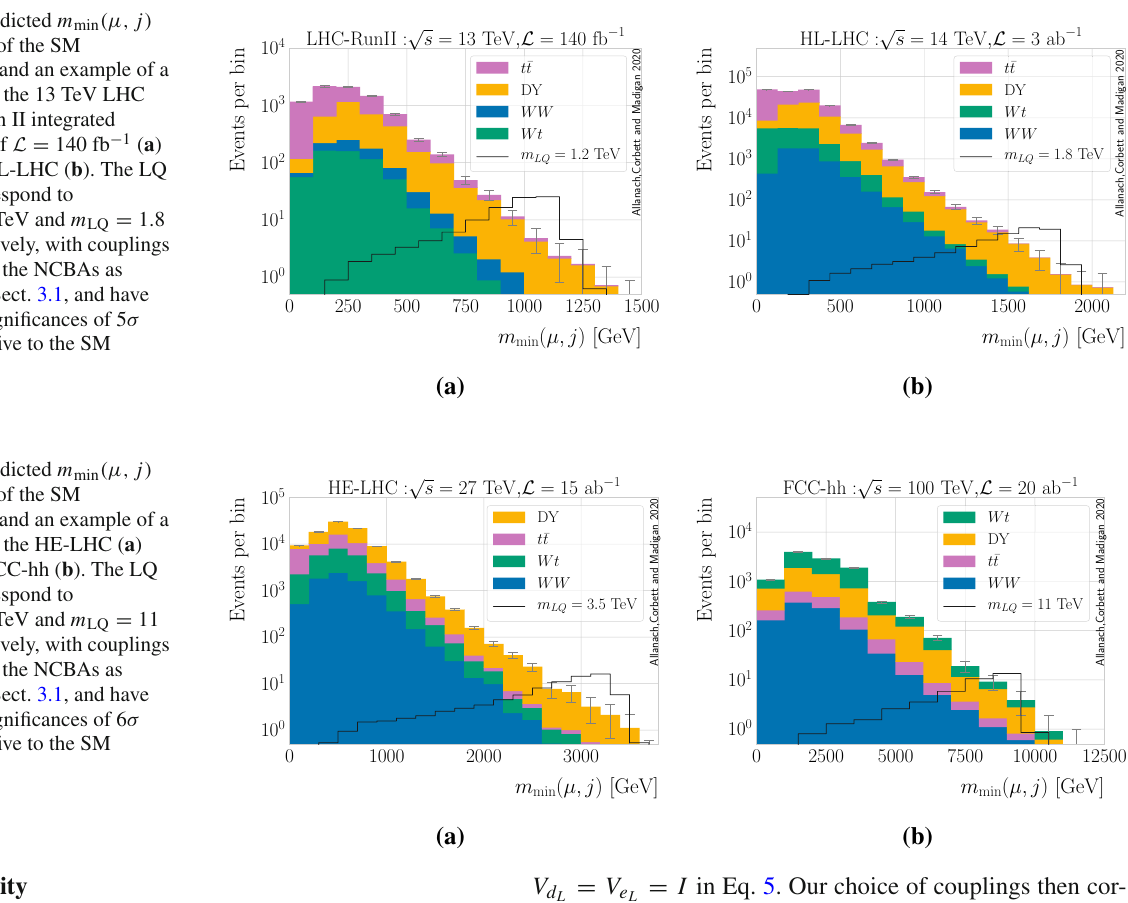
Fig. 11 Predicted m min (μ, j ) distribution of the SM background and an example of a LQ signal at the HE-LHC ( a ) and at the FCC-hh ( b ). The LQ signals correspond to m LQ = 3 . 5 TeV and m LQ = 11 TeV respectively, with couplings chosen to fit the NCBAs as outlined in Sect. 3.1, and have statistical significances of 6 σ and 3 σ relative to the